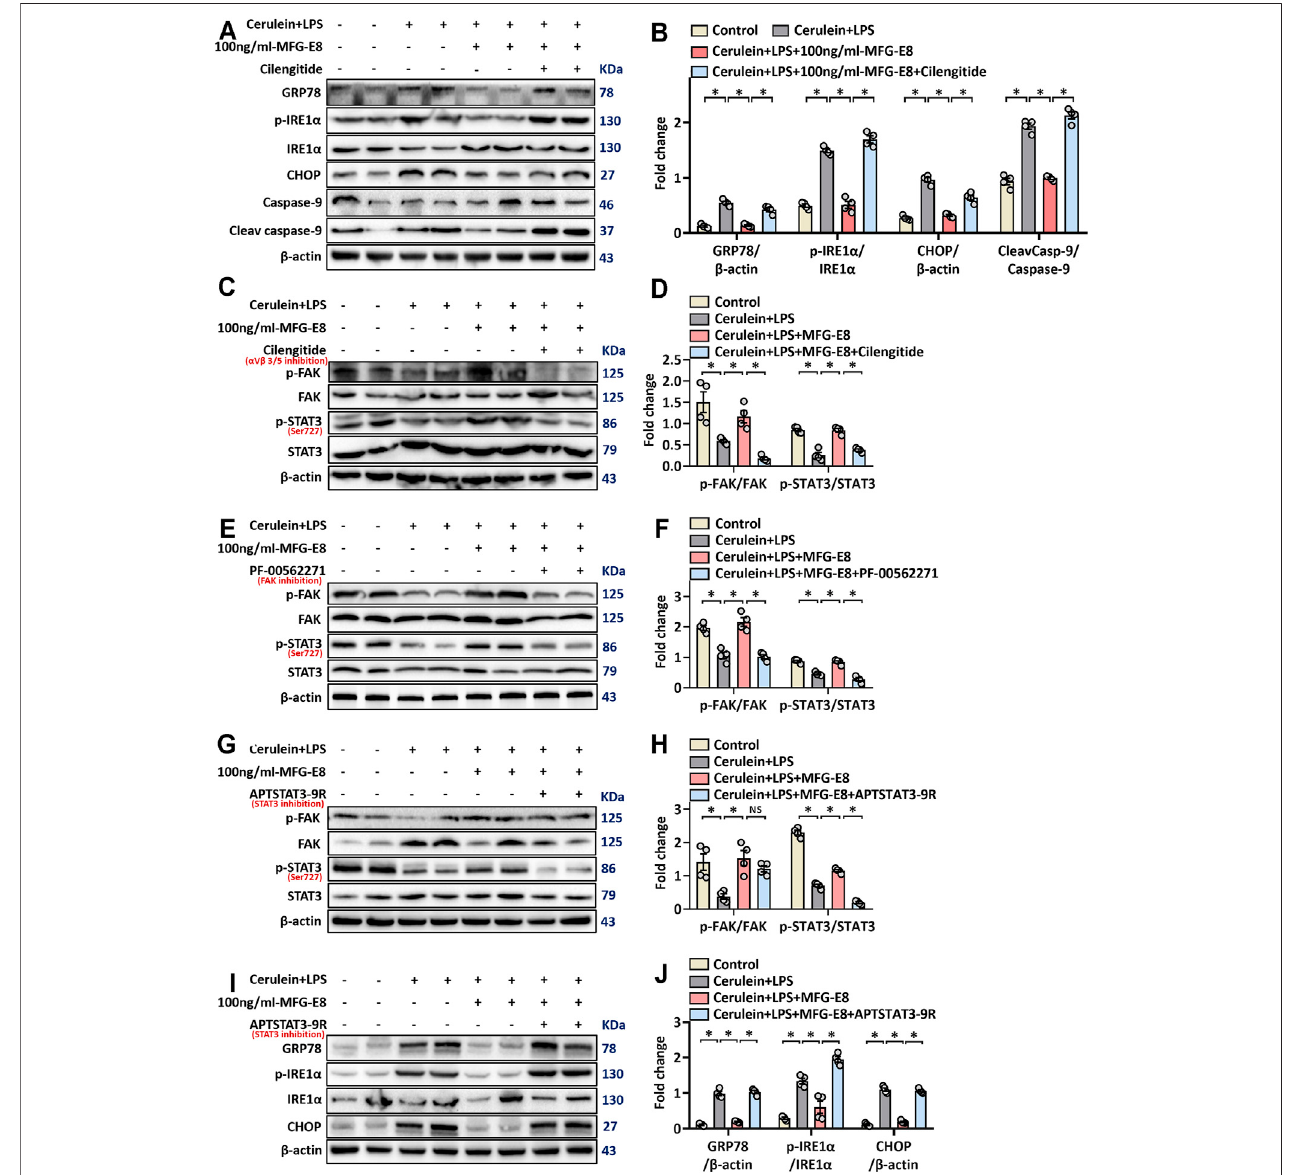
FIGURE 6 | rhMFG-E8 alleviates ER stress in pancreatic exocrine acinar cells through integrin α V β 3/5-FAK-STAT3. Pancreatic AR42J cells (5 × 10 5 /well) were treated with 100 nmol/L cerulein and 10 ng/ml LPS with or without 100 ng/ml MFG-E8 for 24 h. To determine whether the protective effect of MFG-E8 in ER stress is mediated through integrin α V β 3/5-FAK-STAT3, 5 ng/ml cilengitide, a speci fi c integrin α V β 3/5 antagonist, 1 μ mol/L-PF-00562271, a speci fi c FAK antagonist, 30 μ mol/ L-APTSTAT3-9R, a speci fi c STAT3 antagonist, was administered with 100 ng/ml MFG-E8, respectively. (A,B) Western blot analysis of the expression of GRP78, phospho-IRE1 α , IRE1 α , CHOP, caspase-9 and cleaved caspase-9 in the AR42J cells; (C – H) Western blot analysis of the expression of phospho-FAK, FAK, phospho- STAT3 and STAT3 in the AR42J cells; (I,J) Western blot analysis of the expression of GRP78, phospho-IRE1 α , IRE1 α , CHOP, caspase-9 and cleaved caspase-9 in the AR42J cells. n (cid:1) 6/group, error bars indicate the SEM; p p < 0.05 versus Sham group; # p < 0.05 versus Vehicle group. MFG-E8, milk fat globule EGF factor 8; GRP78, glucose-regulated protein 78; CHOP, C/EBP homologous protein; LPS, Lipopolysaccharide.